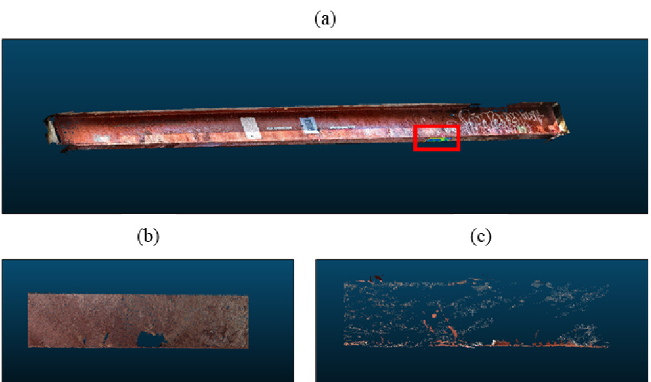
Figure 14. Example of missing point data located at ( a ) right quarter span. Part ( b ) shows the results for the first load test, while part ( c ) shows the results for the second load test.